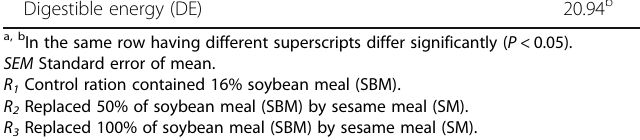
Table 5 Water consumption of the experimental groups Item R 1 R 2 R 3 SEM Animal no. Average body weight, kg ml/kgW 0.75 L/ 100 kg LBW